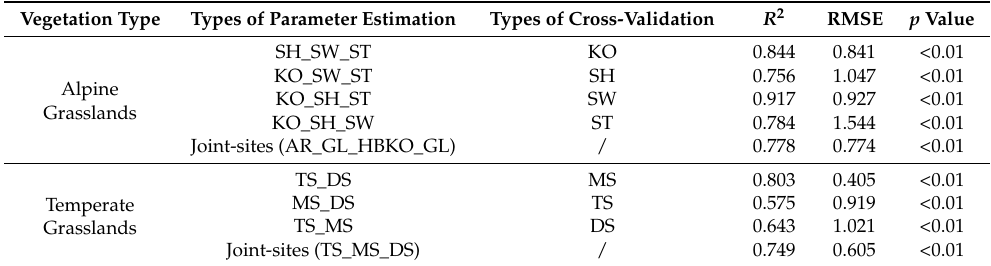
Figure 5. Comparison between the observed and predicted ecosystem respiration ( RE ) in the Tibetan alpine grasslands ( left ) and the Inner Mongolian temperate grasslands ( right ). Table 3. Joint-sites estimation and leave-one-out cross validation for each vegetation type. Vegetation